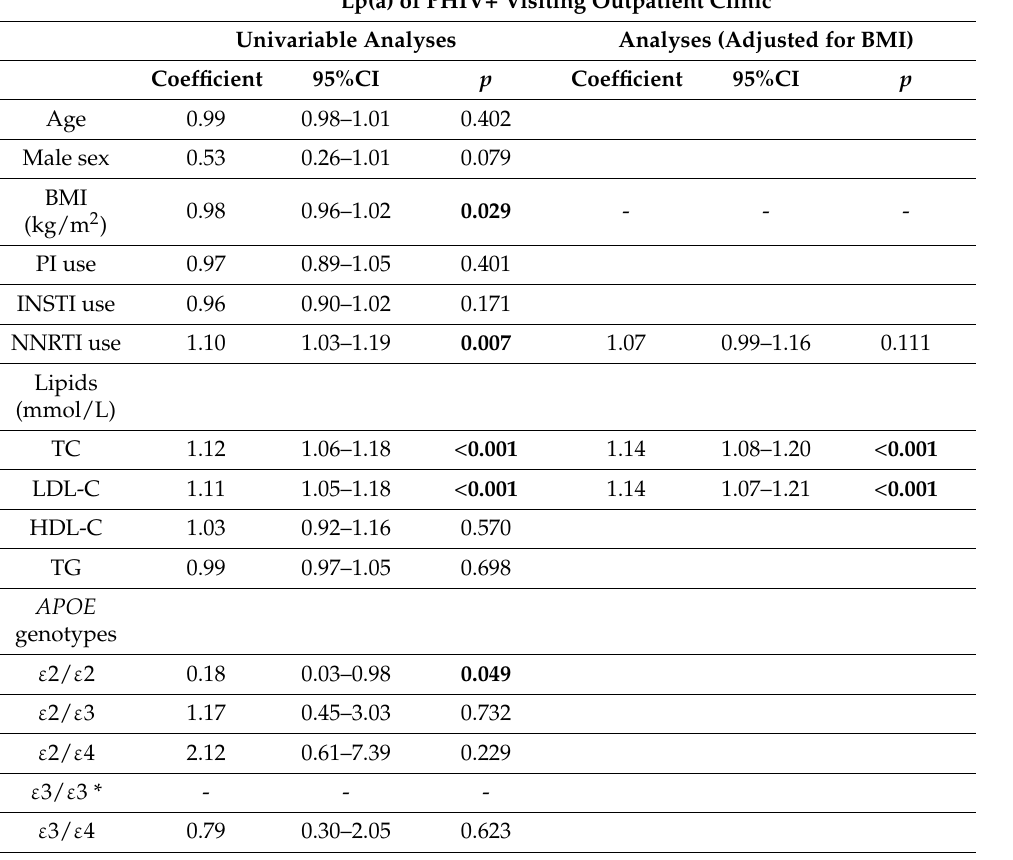
Table 3. Factors associated with Lp(a) in retrospective longitudinal